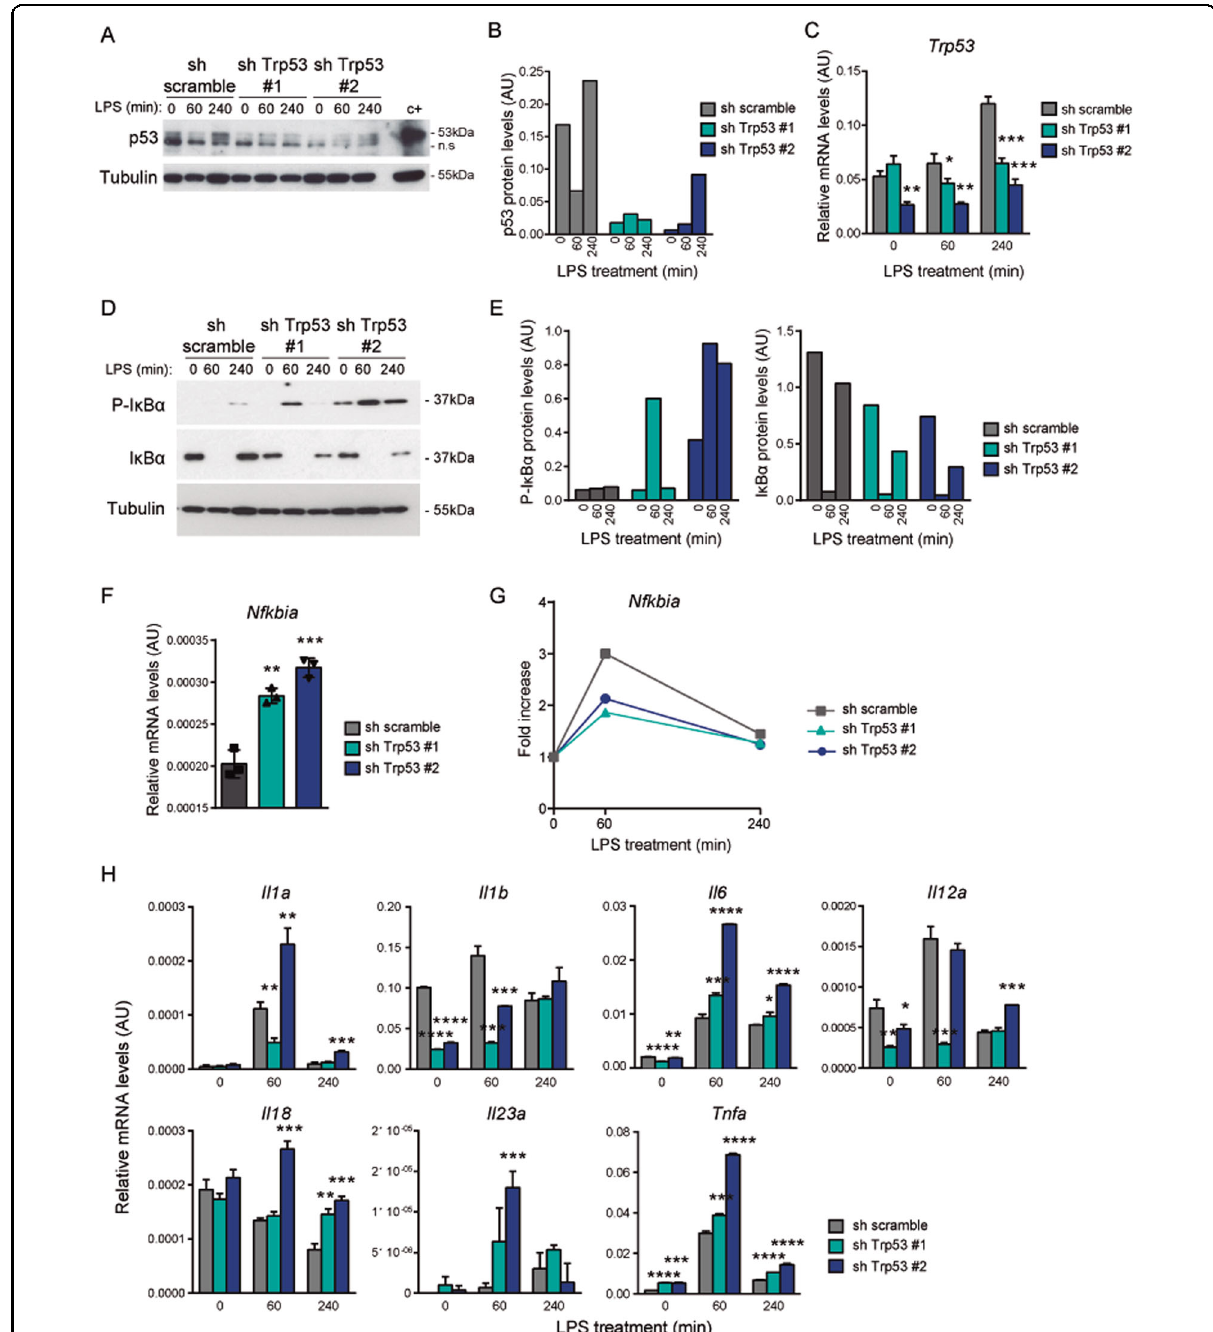
Fig. 6 p53 knockdown leads to an increased pro-in fl ammatory cytokine expression and affects NF- κ B pathway. WT BMDMs infected with sh scramble, sh Trp53 #1 or sh Trp53 #2 were untreated and treated with LPS (100 ng/ml) for the indicated times. A p53 protein expression and B quanti fi cation. Representative images of western blot analysis from one experiment are shown. C + , positive control for p53 staining from UVB- treated cells. Relative expression values were referred to tubulin expression. C Relative mRNA expression of Trp53 . Technical replicates were quanti fi ed in one experiment. D P-I κ B α and I κ B α protein expression and E quanti fi cation. Representative image of a western blot analysis from one experiment is shown. Relative expression values were referred to tubulin expression. F Relative mRNA expression of Nfkbia in untreated BMDMs. Technical replicates were quanti fi ed in one experiment. G Relative mRNA expression of Nfkbia in LPS-treated BMDMs. Technical replicates were quanti fi ed in one experiment. H Relative mRNA expression of the indicated genes. Technical replicates were quanti fi ed in one experiment. AU arbitrary units. In C , F , G and H bars represent mean values ± SEM. Signi fi cant differences and p values were derived from an unpaired t -test, two-tailed. Sh scramble vs sh Trp53 #1 or sh Trp53 #2. **** p value < 0.0001, *** p value < 0.0005, ** p value < 0.005, * p value < 0.05.